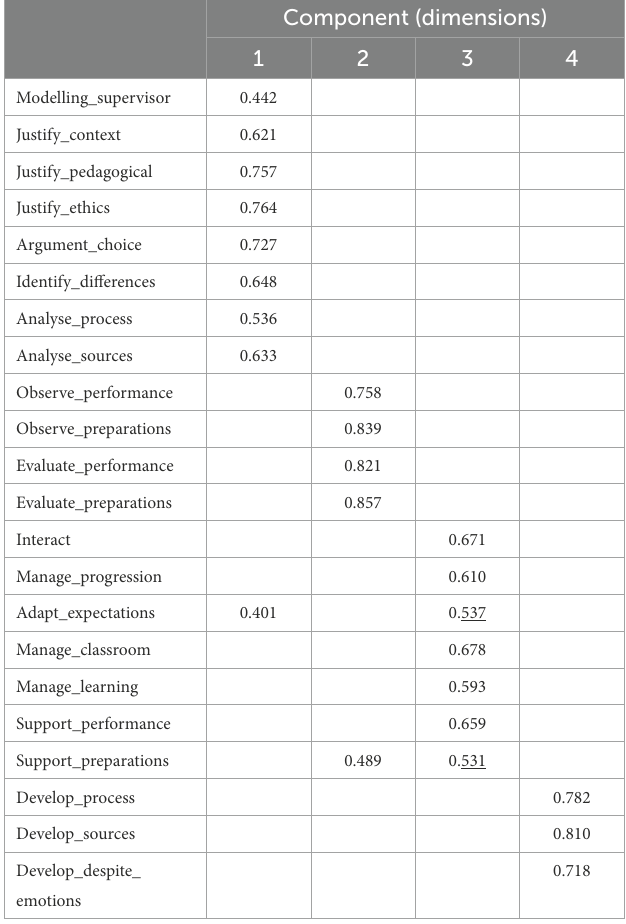
TABLE 4 Component (dimensions) matrix of the principal component analysis with Varimax rotation. Component